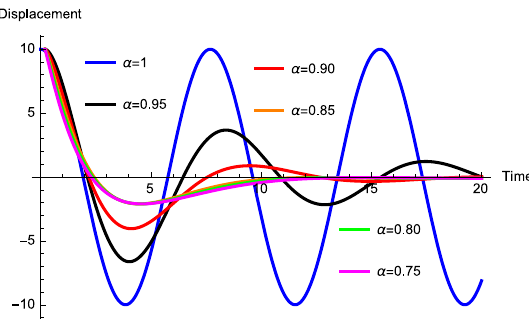
Figure 13. Numerical simulation for Equation (55) considering different values of α , arbitrarily